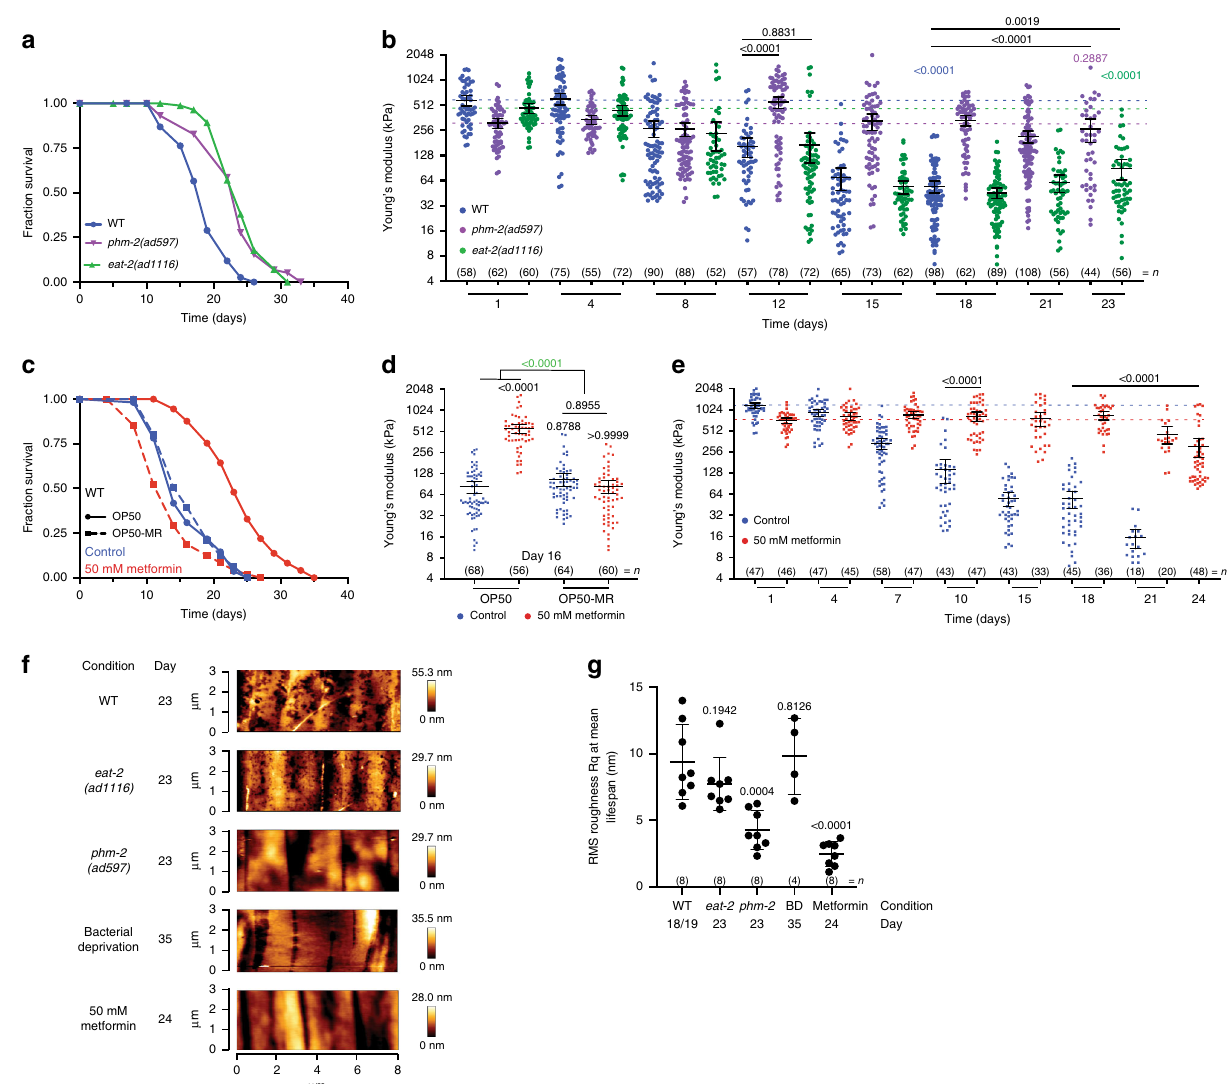
Fig. 3 AFM identi fi es differences in stiffness and cuticle senescence with age among diverse dietary restriction regimens. a Lifespan curves of wild- type (WT) (blue), or eat - 2 (green) and phm - 2 (purple) feeding impaired mutant C . elegans ( n = 98, 104 and 125, respectively; log rank test p < 0.001 vs fully-fed WT) and b longitudinal study of mechanical properties as Young ’ s Modulus (YM; kPa) until mean lifespan (D18 for WT; D23 for eat - 2 and phm - 2 ). Error bars indicate 95% CI, dotted lines mark mean YM at day 1 for WT (blue), eat - 2 (green) or phm - 2 (purple). Two-tailed unpaired t test for statistical comparison of WT with eat - 2 or phm - 2 at chronological age day 12 and at mean lifespan, WT at mean lifespan to day 1 (blue), phm - 2 at mean lifespan to day 1 (purple), and eat-2 at mean lifespan to day 1 (green). c Lifespan curve of untreated (0 m M ) (blue) and metformin-treated (50 m M ) (red) WT C . elegans grown on sensitive OP50 (full line ) or grown on metformin-resistant OP50-MR (dotted line). ( n = 107, 142, 119 and 175, respectively; log rank test p < 0.001, p = 0.0883 and p = 0.0004 vs OP50 0 m M ) and d mechanical properties as YM (kPa) at chronological age of 16 days. Error bars indicate 95% CI. Two-way ANOVA Tukey ’ s multiple comparison test for statistical comparison and interaction of terms (green). e Longitudinal study of mechanical properties as YM (kPa) of untreated (0 m M ) (blue) and metformin-treated (50 m M ) (red) WT C . elegans until mean lifespan (D18 for WT; D24 for metformin-treated). Error bars indicate 95% CI, dotted lines mark mean YM at day 1 for untreated (blue) and metformin-treated (red). Two-tailed unpaired t test for statistical comparison of untreated to metformin-treated at chronological age day 10 and mean lifespan. f Representative AFM cuticle topography images of WT, eat - 2 and phm - 2 mutant worms, and WT under bacterial deprivation or metformin-treated at mean lifespan. g Roughness quanti fi cation of topographical images presented as RMS roughness Rq ± standard deviation. Two-tailed unpaired t test for statistical comparison of WT with mutants/ conditions. n represented above the graph, show number of biologically independent worm samples. For lifespan measurements, n represents the number of worms scored as dead. For a summary of YM values and additional statistics for independent trials, see Supplementary Data 1 and for a summary of worm lifespan trials and statistical comparison between genotypes see Supplementary Data 2. Source data are provided as a Source Data fi